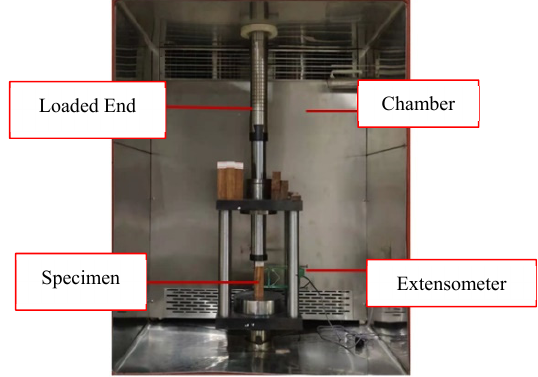
Figure 4. Compressive loading set-up.